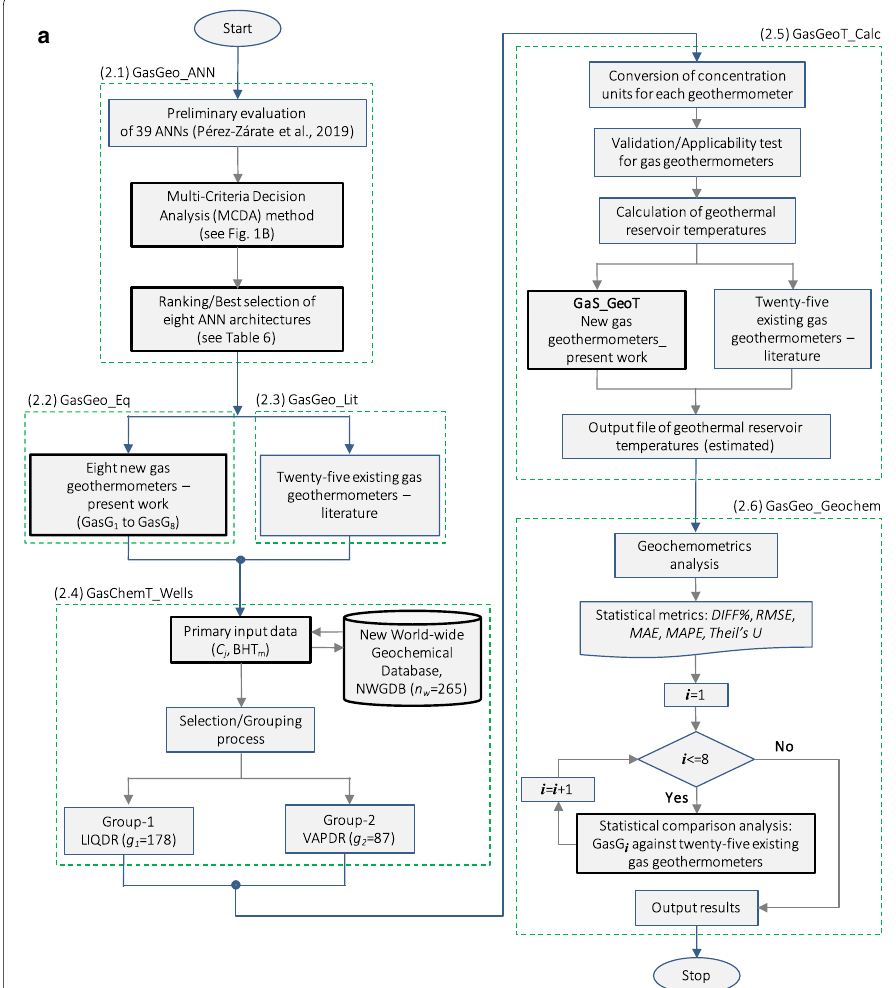
Fig. 1 a Schematic flow diagram showing the work methodology used in this study. b Schematic flow diagram used by the MCDA method for the ranking and optimal selection of thirty‑nine ANN architectures that correlate BHT m and gas‑phase